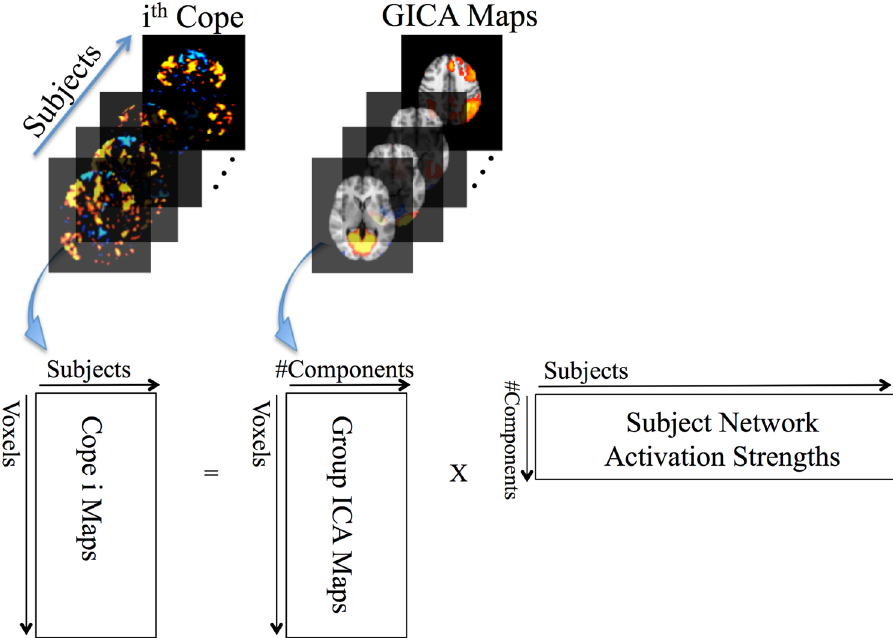
Figure 4. For a given task contrast (i th cope, e.g., as in Table 1), the activation strength of each network for each subject is derived via multiple spatial regression of the group ICA spatial maps (full set) against the cope subject series (e.g., data file comprised of the cope maps for all subjects, with one cope map per subject). Each row in the output matrix (far right matrix) corresponds to the activation strengths (one per subject) for each network. For example, for the GICA maps depicted above, the values in the first row of the matrix correspond to the magnitude of activation of the medial visual network for each